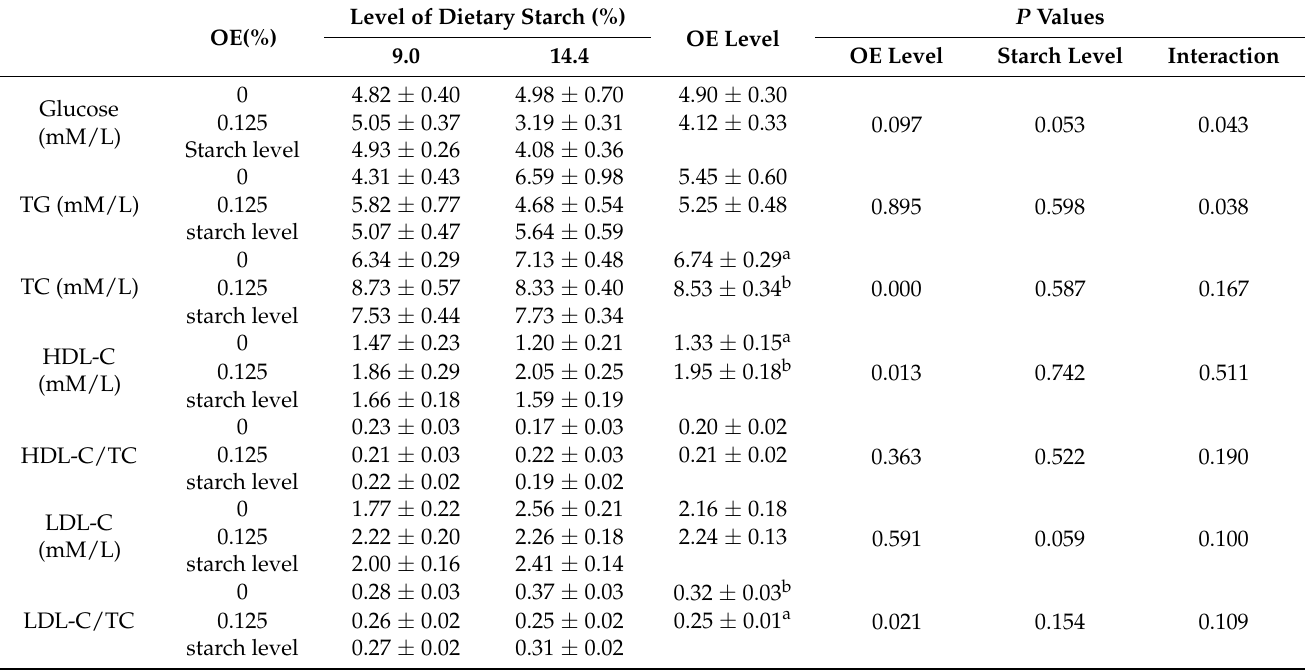
Table 6. Effects of experimental diets on hematological parameters in largemouth bass.